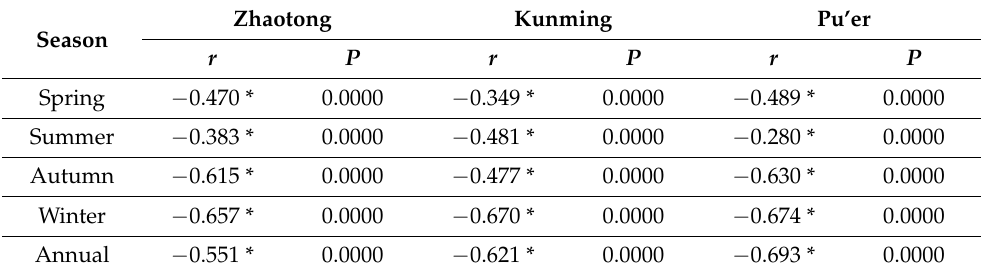
Table 2. Correlation Analysis of O 3 Concentrations and Humidity in Different Seasons.